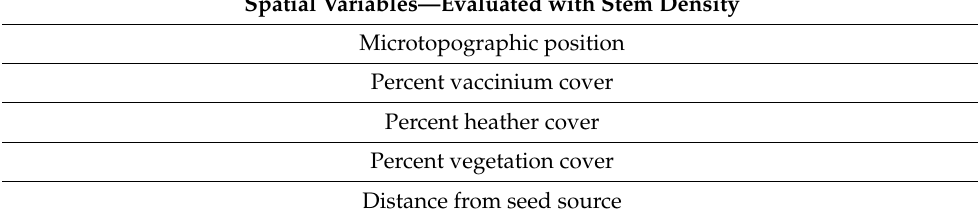
Table 3. Variables used to test relationships between conifer stem density and microsite characteristics within meadows.